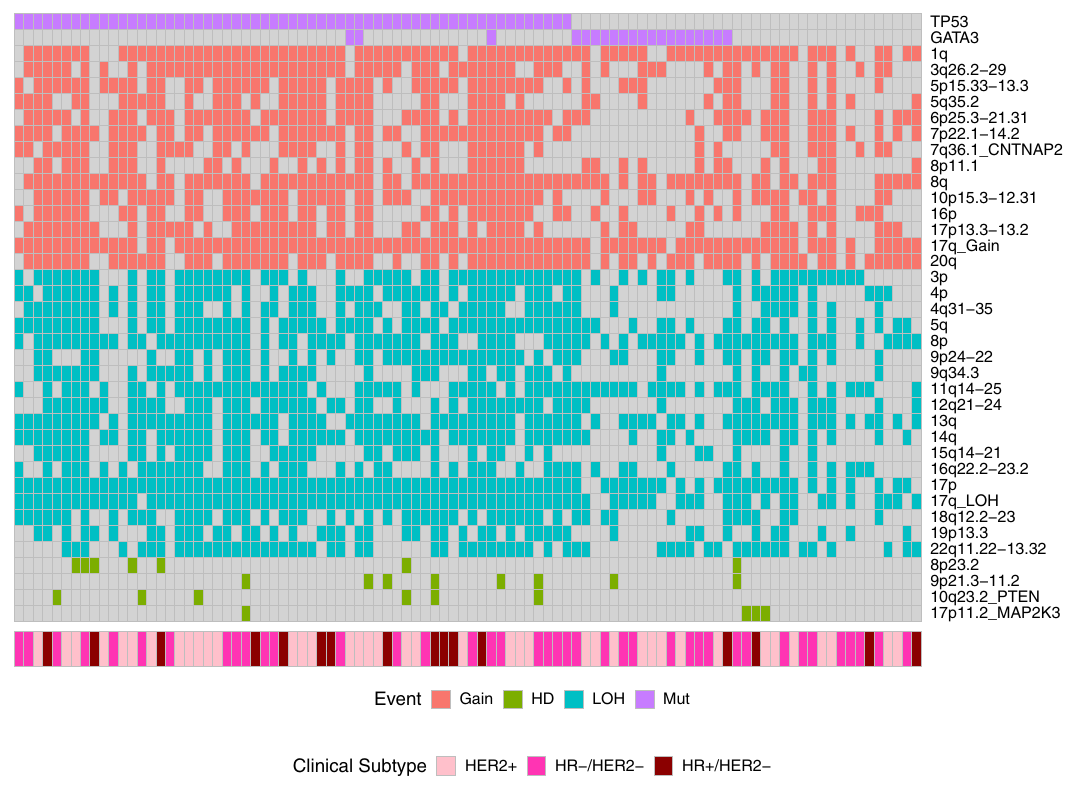
Fig. 8 Copy number burden across genomic subtypes identi fi ed in the Nigerian group. Distribution of signi fi cantly enriched copy number aberrations in the form of gain, loss of heterozygosity (LOH), and homozygous deletion (HD) were assessed for all Nigerian patients. GATA3 -positive tumors displayed a lower copy number burden than TP53 -positive tumors but were similar to tumors negative for both TP53 and GATA3